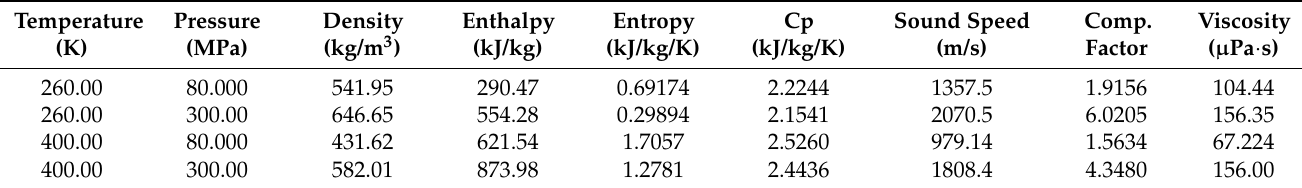
Table 2. Physical and thermal properties of the